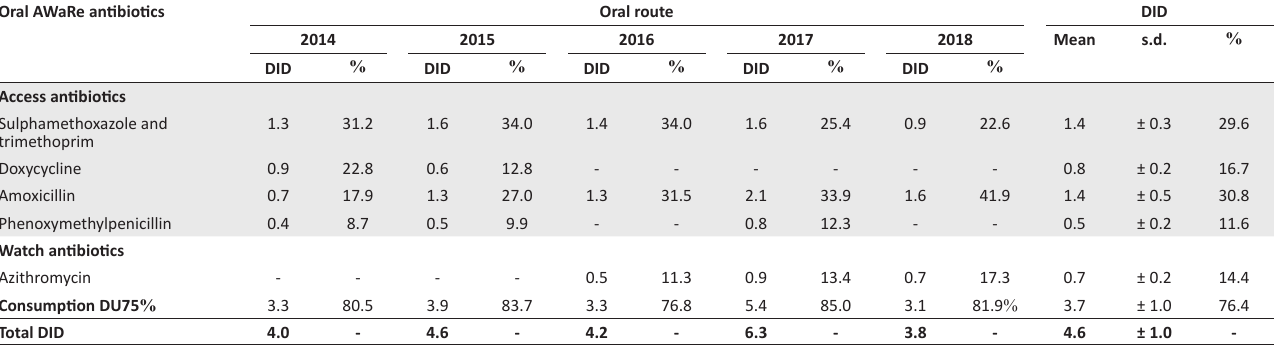
TABLE 4: Commonly consumed antibiotic at Anatomical Therapeutic Chemical classification system level 5 by absolute and relative oral route (DU75 % ) and Access, Watch and Reserve classification. Oral AWaRe